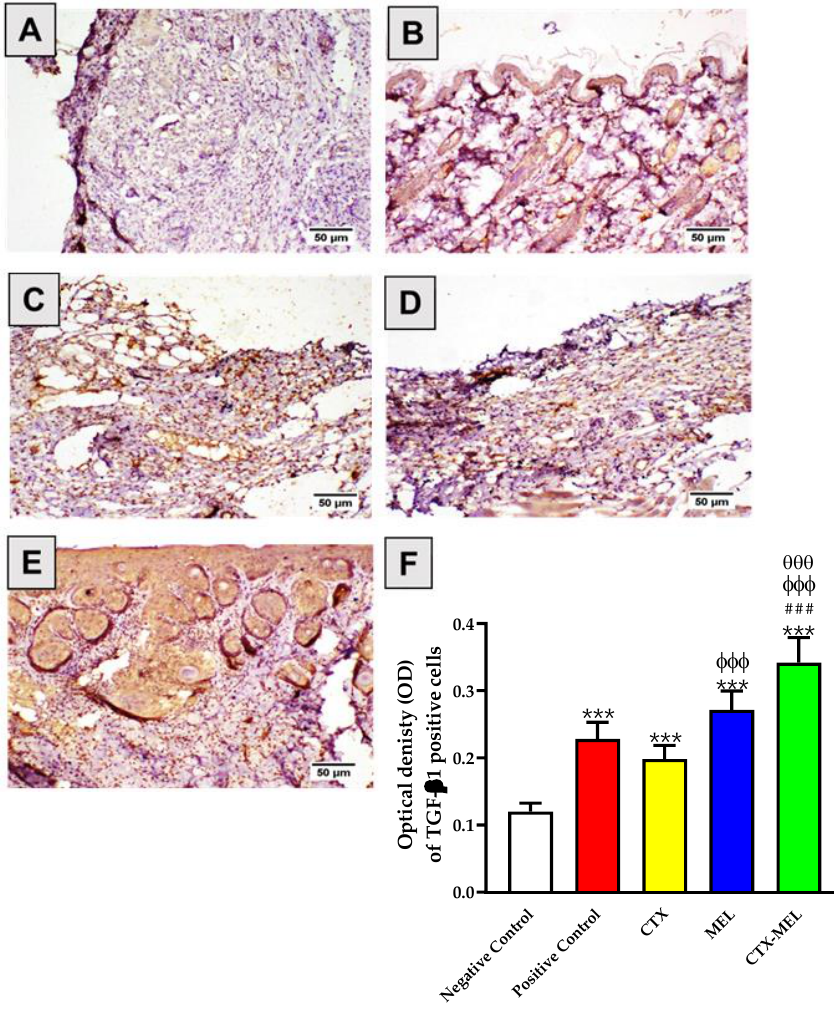
Figure 8. Immunohistochemical assessment of TGF- β1 expression in skin tissues obtained from diabetic rats belonging to the different experimental groups. ( A ) Negative control, ( B ) positive control, ( C ) CTX, ( D ) melittin, ( E ) CTX–MEL, ( F ) quantitative representation of TGF- β 1 expression. Negative control refers to rats that received topical plain vehicle consisting of HPMC-based hydrogel (1.5% w / v ) on the wound area, while positive control refers to animals that received 0.5 g of Mebo TM ointment on the wound area. Data are expressed as mean ± SD, ( n = 6). *** Significantly different vs. negative control, p < 0.001; ### significantly different vs. positive control, p < 0.001; φφφ significantly different vs. CTX, p < 0.001; θθθ significantly different vs. CTX, p <